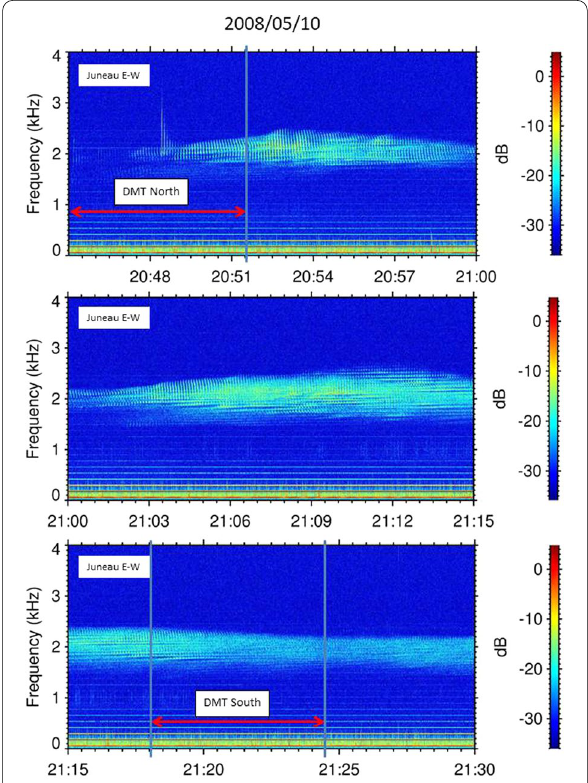
Fig. 20 Spectrogram recorded at Juneau on May 10, 2008 between 20:46:00 and 21:30:00 UT in the frequency range 0–4 kHz. The power spectral density is color-coded according to the scale on the right. The red double arrows indicate the time intervals when DEMETER data are simultaneously present in burst mode in the Northern and in the Southern hemisphere